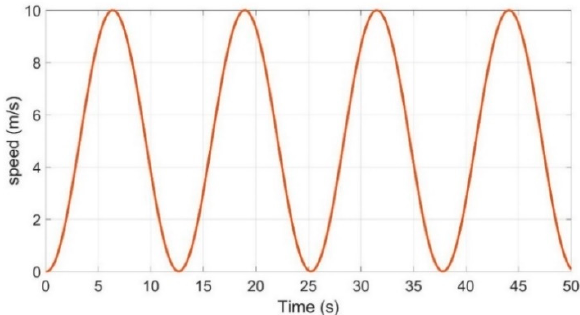
Figure 4. Vehicle longitudinal speed command.